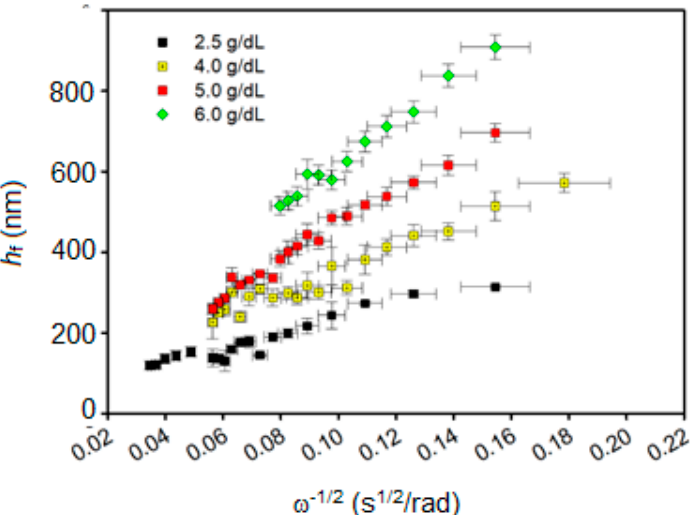
Figure 7. Scatter plot of spin speed contribution to film thickness. Scatter plot of final film height by spin speed scaled by Equations (1)–(4). Error bars are the standard deviation of at least 3 measurements per point.